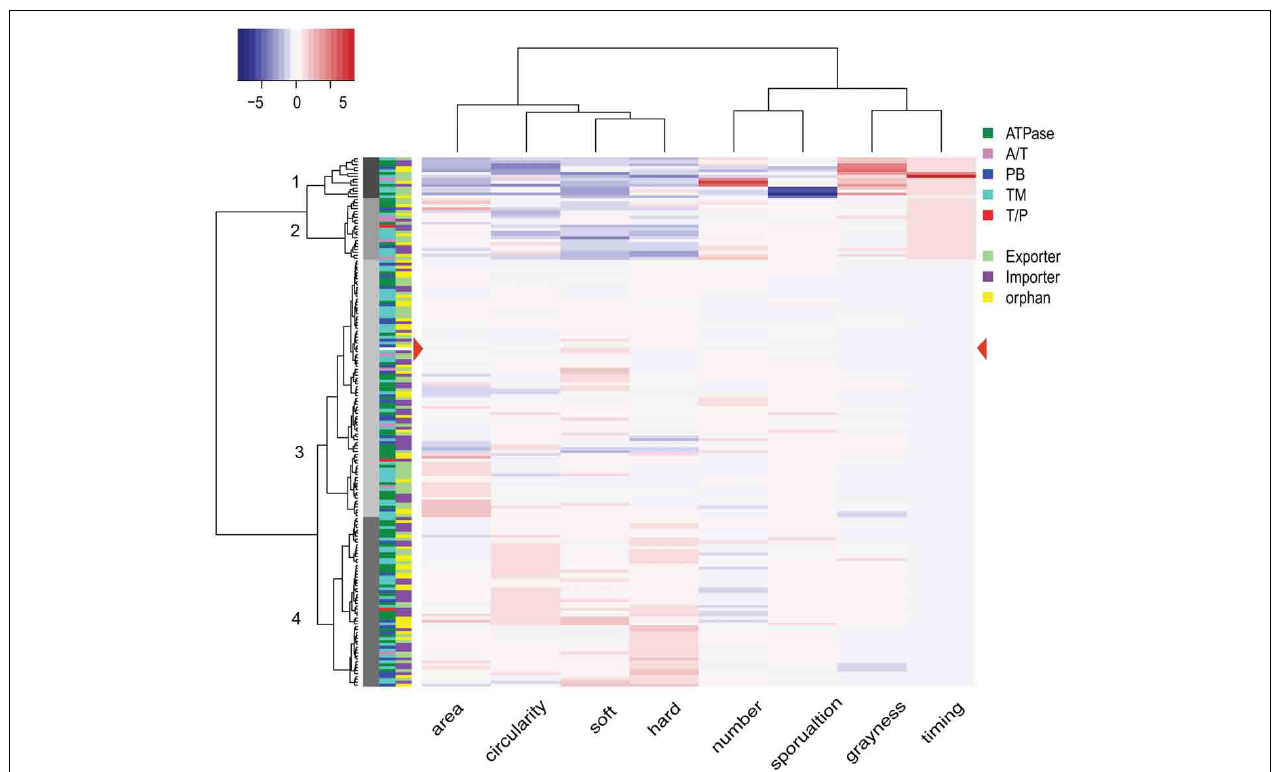
FIGURE 6 | Phenotype clustering of 180 mutant strains. The dendrogram on the left represents the results from the clustering analysis of 180 mutant strains, with the numbers on each node indicating the four clusters. The dendrogram at the top is the result of hierarchical clustering of the eight phenotypic variables. The heat map key on top left shows the color indication for each z-score, with more intense shading indicating a greater deviation